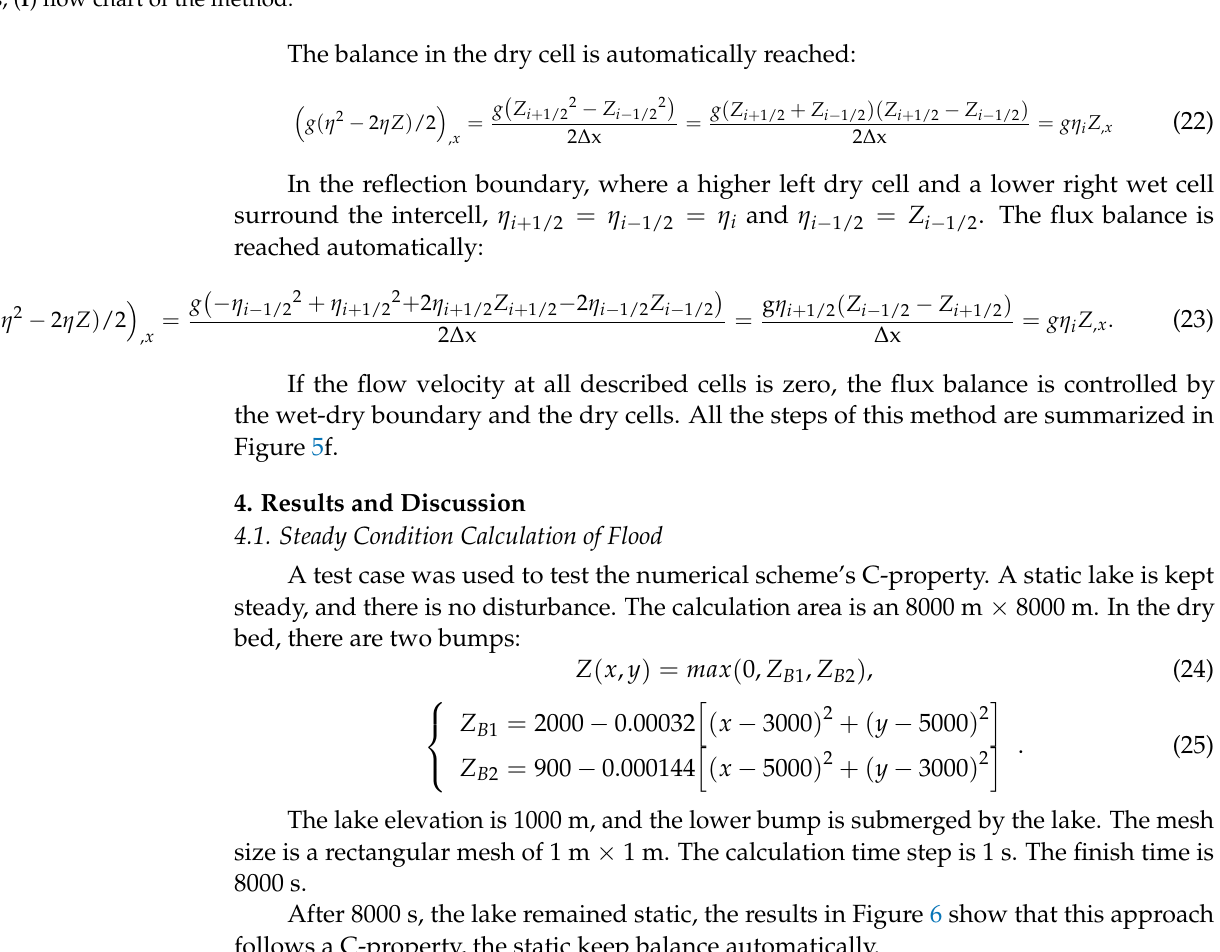
Figure 5. The dry cell’s center elevation is calculated by the average of two intercell elevations. Intercell elevations are predicted from the latest two steps that are based on the intercell type and the real conditions. ( a , c ) One side is a wet-dry front and the one side is dry-dry; ( b ) both sides are a wet-dry front; ( d ) both sides are sharp slopes; ( e ) both sides are dry cells; ( f ) flow chart of the